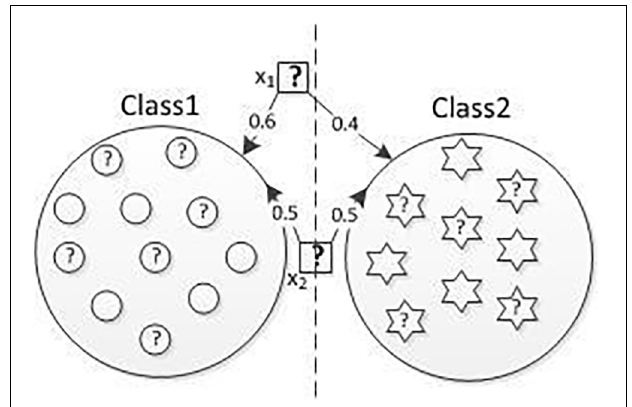
FIGURE 1 | Problem